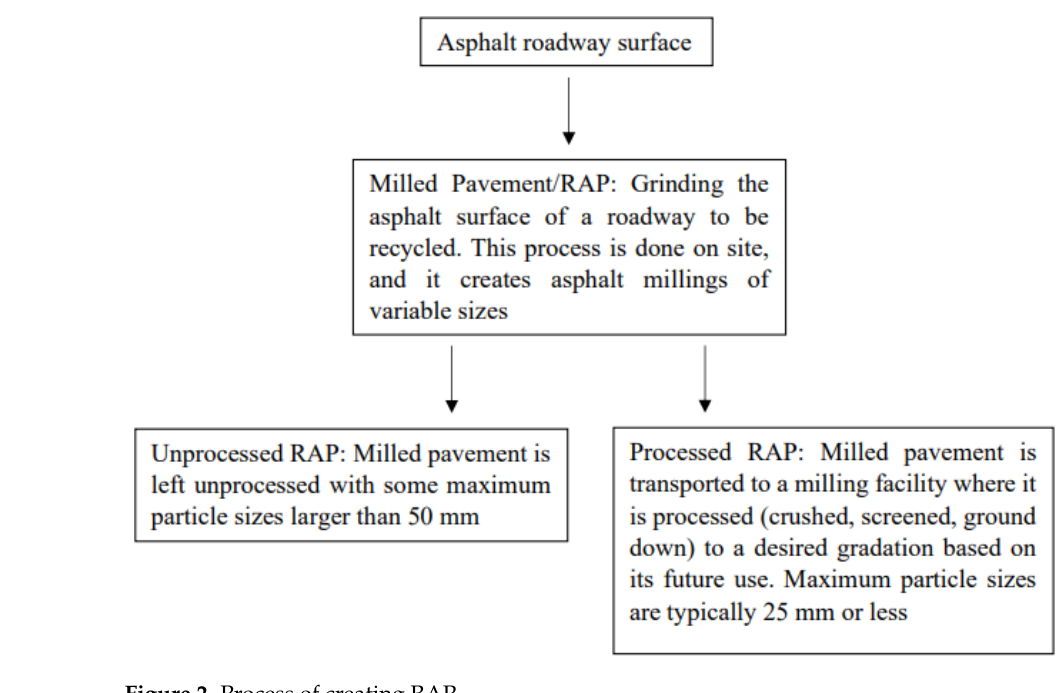
Figure 2. Process of creating RAP.